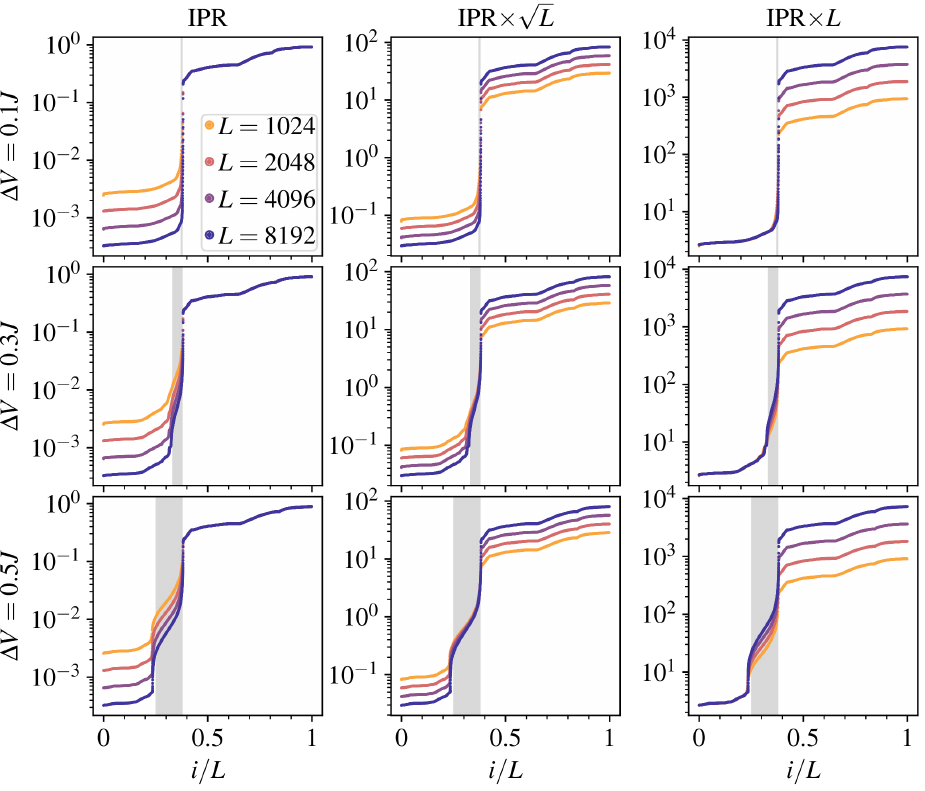
Figure 10: Fraction of multifractal states in the Floquet quasienergy spectrum for different ∆ V . While the three rows of plots correspond to ∆ V = 0.1 J , 0.3 J , and 0.5 J , respectively, the three columns correspond to the three different scalings of the IPR. The multifractal states denoted by the gray shaded window are identified by noting the collapse of the IPR different L , and their fraction grows with ∆ V